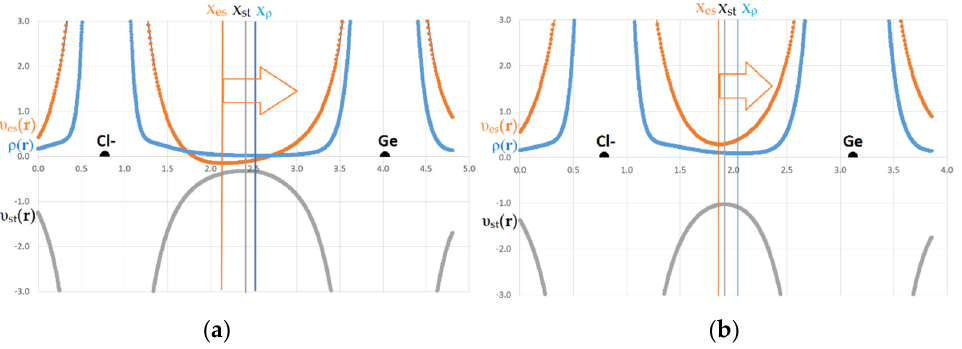
Figure 4. The disposition of electron density, and electrostatic potential minima and potential acting on an electron in a molecule, (a.u.) along interatomic line Hal – …Ge in complexes ( a ) F–Ge(CH 3 ) 3 …Cl − and ( b ) F–GeF 3 … Cl − . The arrows point to the atom providing electrophilic region. Vertical lines show the extremes of functions; corresponding color is used.